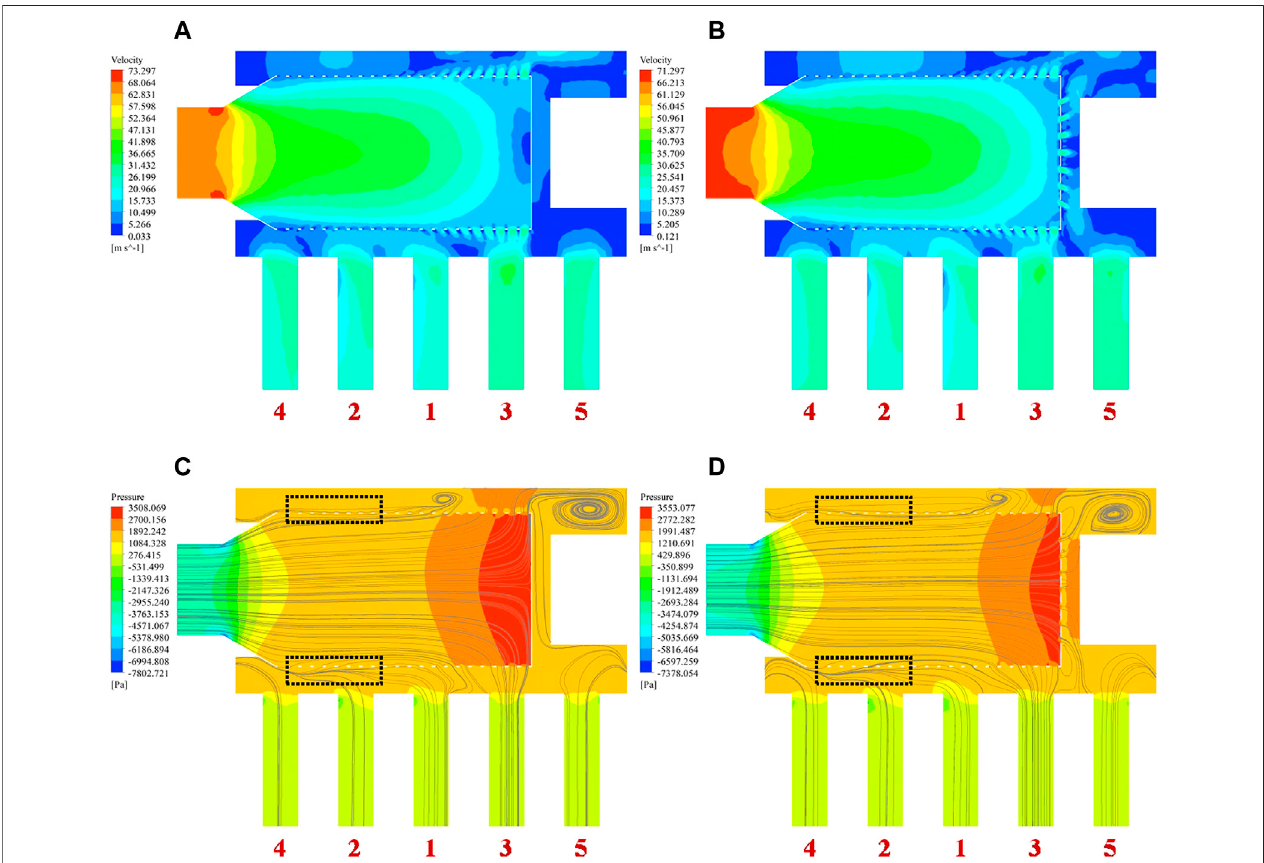
FIGURE 7 | Velocity and pressure fi elds. (A) Flow velocity contour of No.3. (B) Flow velocity contour of No.5. (C) Pressure contour of No.3. (D) Pressure contour of No.5.